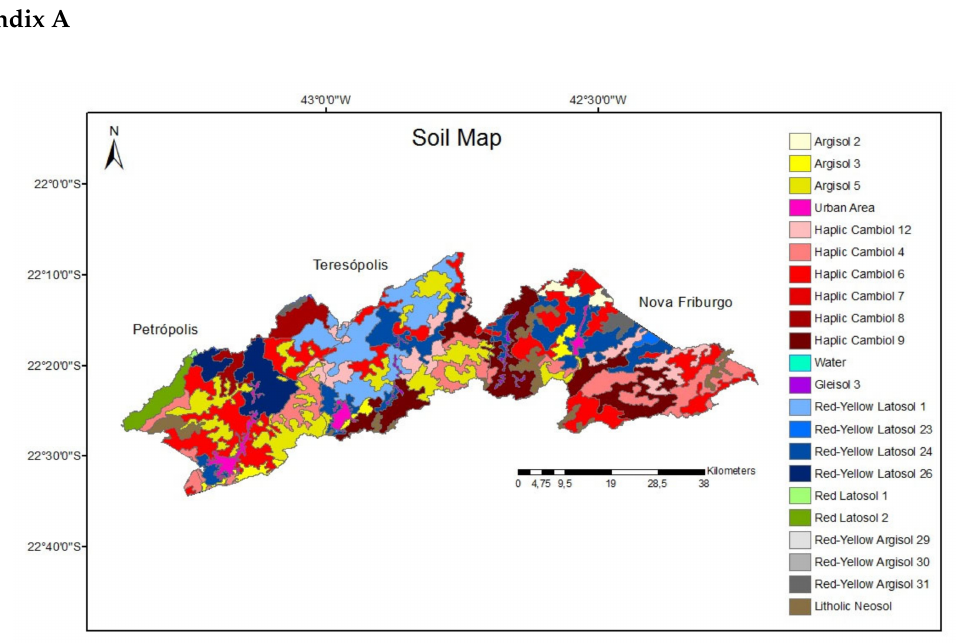
Figure A1. Soil Map in the study area. Scale 1:100.000. Source the Rio de Janeiro Environmental